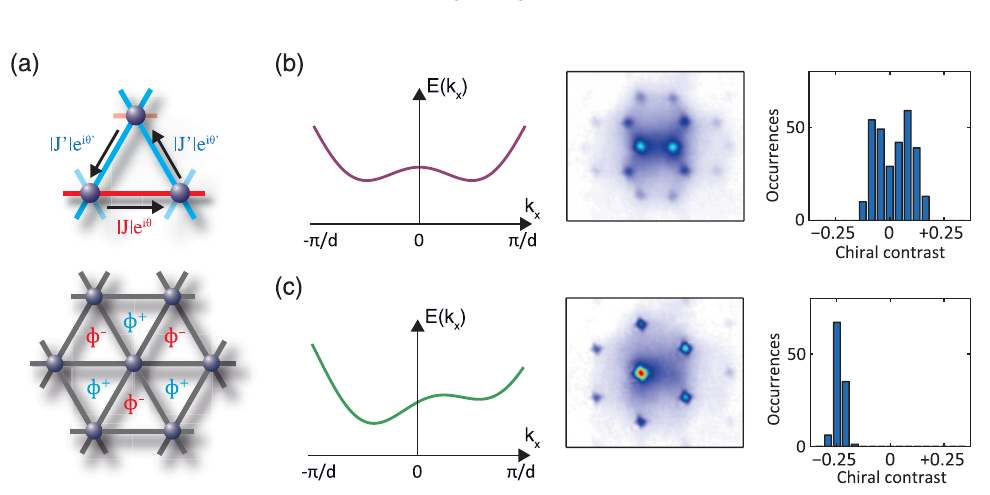
Figure 3. Creation of gauge fluxes in triangular lattices. (a) Complex tunneling elements created by the 2D forcing and resulting staggered magnetic fluxes in a 2D triangular lattice. (b), (c) Control over the frustration of the system illustrated for (cid:1) = (cid:1) and (cid:1) = 0.81 (cid:1) respectively. The calculated dispersion relation is ploted along the x axis, demonstrating the control over the frustration of the system. From roughly 100 successive measurements, the summed time-of-flight images and the histograms are extracted. In the degenerate case, the occupation of both ground-states is equiprobable and spontaneous symmetry breaking can be evidenced. For a flux strength of (cid:1) = 0.81 (cid:1) , only the global minimum of the band structure is